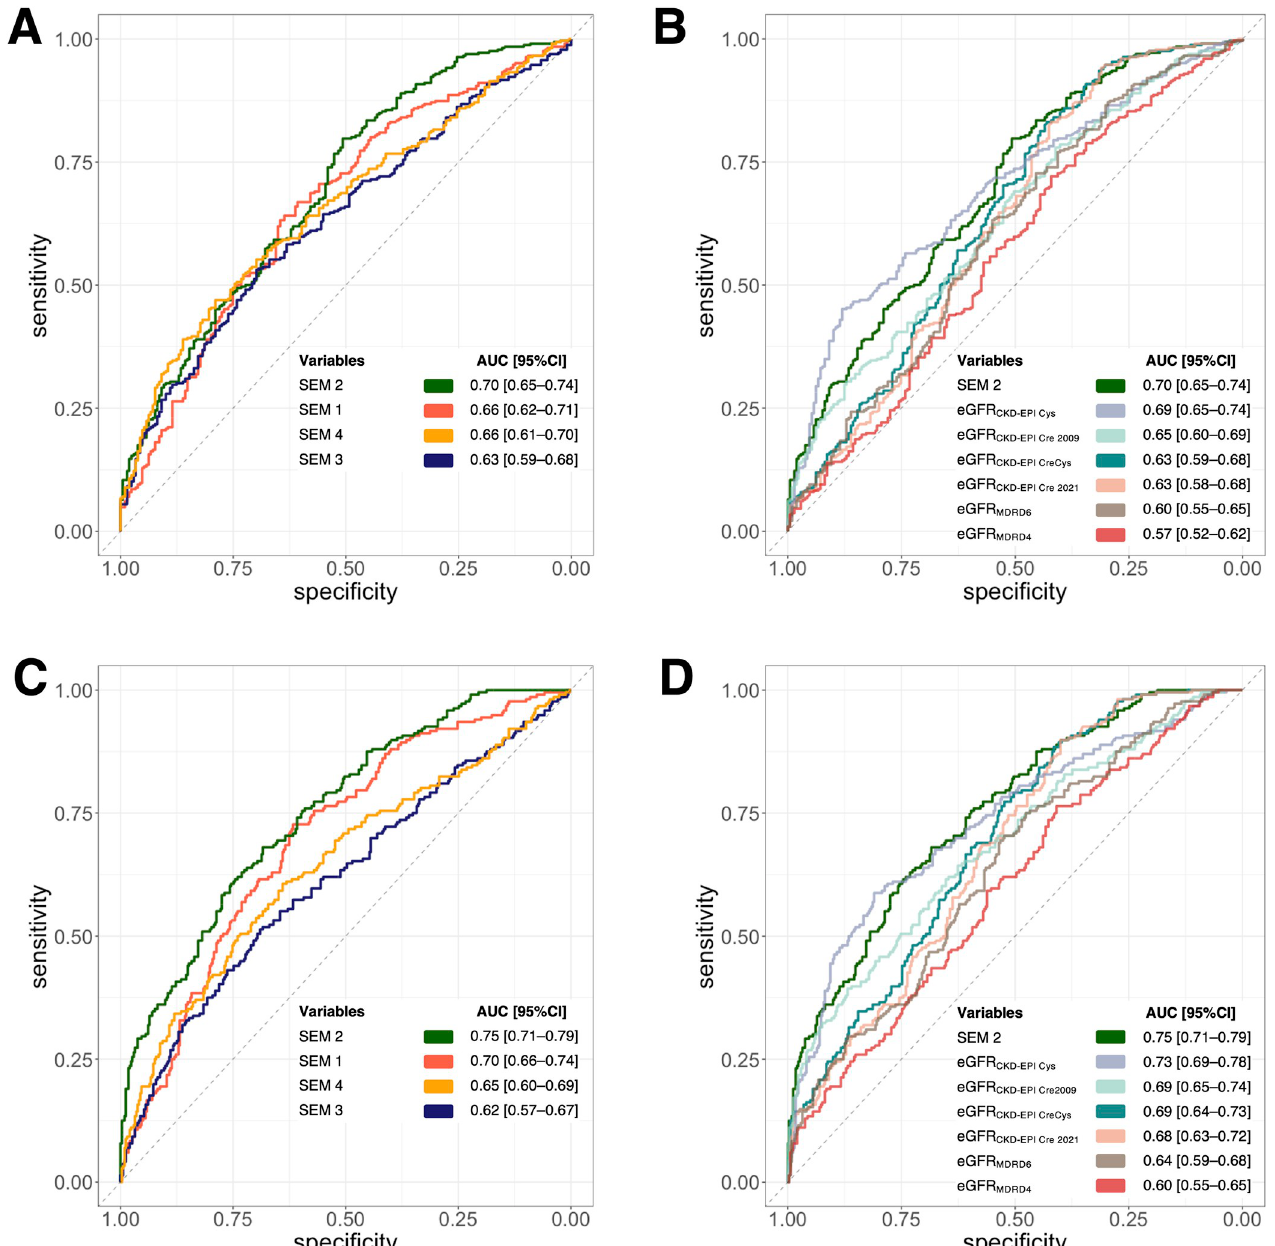
Fig 5. Comparisons of receiver operating characteristics (ROC) curves for Framingham risk score (FRS) > 5 for general CVD risk estimation and pooled cohort equation (PCE) > 5 for risk estimation of hard atherosclerotic cardiovascular disease in 10 years. Panel A : Comparisons of the C-statistics for FRS > 5 within SEM-based latent kidney traits. Panel B : Comparisons of the C-statistics for FRS > 5 with the 2 nd SEM model (SEM 2) and eGFR equations. Panel C : Comparisons of the C-statistics for PCE > 5 within SEM-based latent kidney traits. Panel D : Comparisons of the C-statistics for PCE > 5 with the 2 nd SEM model (SEM 2) and eGFR equations. The x-axis shows specificity ranging from 1 to 0, while the y-axis shows sensitivity ranging from 0 to 1. The right- hand table summarizes the C-statistics and its 95% confidence intervals in descending order. CKD-EPI: the Chronic Kidney Disease Epidemiology Collaboration; Cre: creatinine; Cys: cystatin C; eGFR: estimated glomerular filtration rate; MDRD: the Modification of Diet in Renal Disease study; SEM: structural equation modeling.